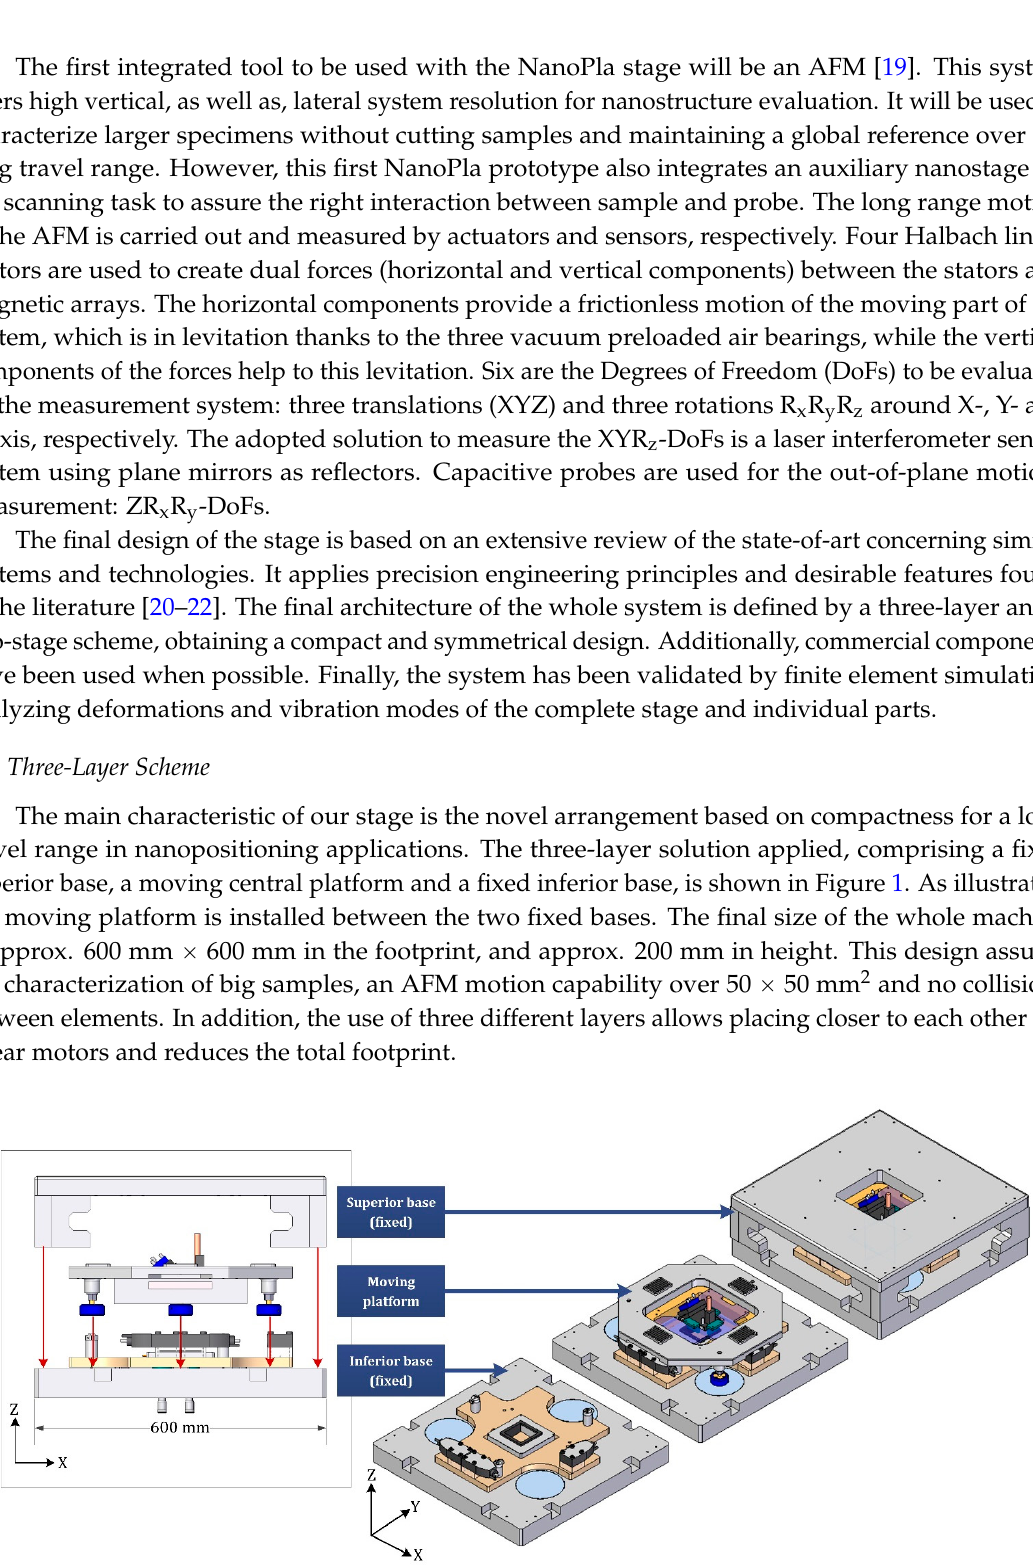
Figure 1. Three-layer NanoPla novel architecture with related parts. ( Left ) Exploded front view of the prototype; ( Right ) 3D-model schemes including different parts.